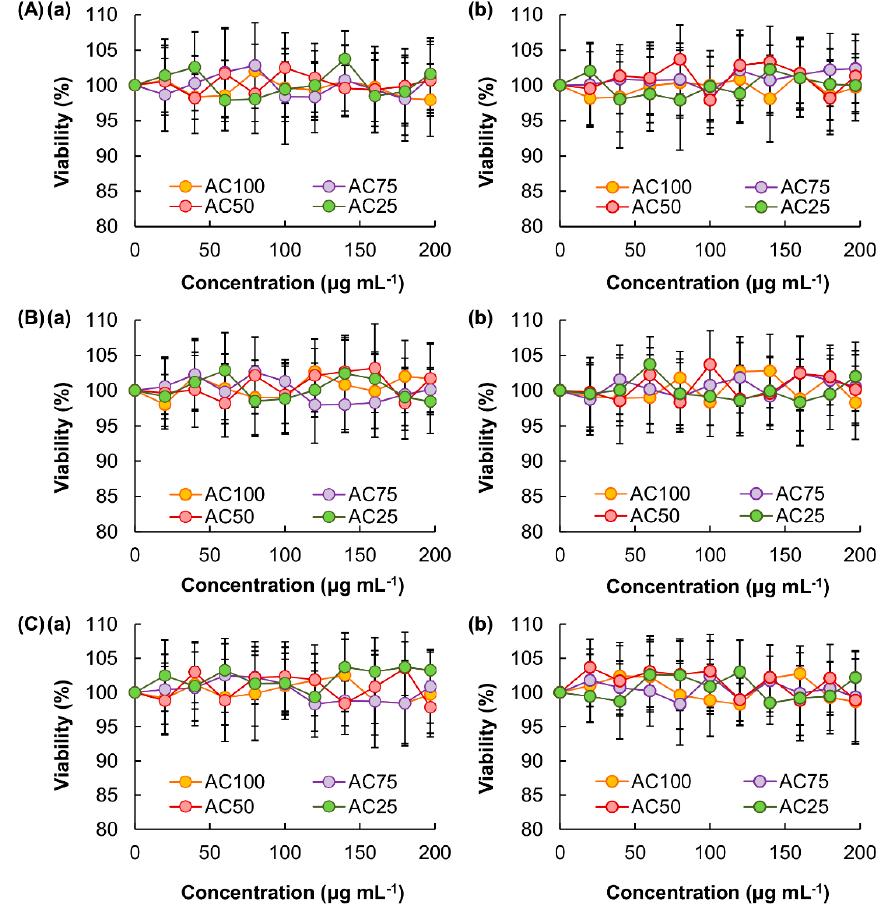
Figure 4. The viability of ( A ) 3T3, ( B ) HDF and ( C ) HaCaT cells after 5 h treatment with different complex gels, ( a ) without or ( b ) with 24 h post-treatment incubation prior to the MTS assay. Data are presented as the means ± SD of triplicate experiments.